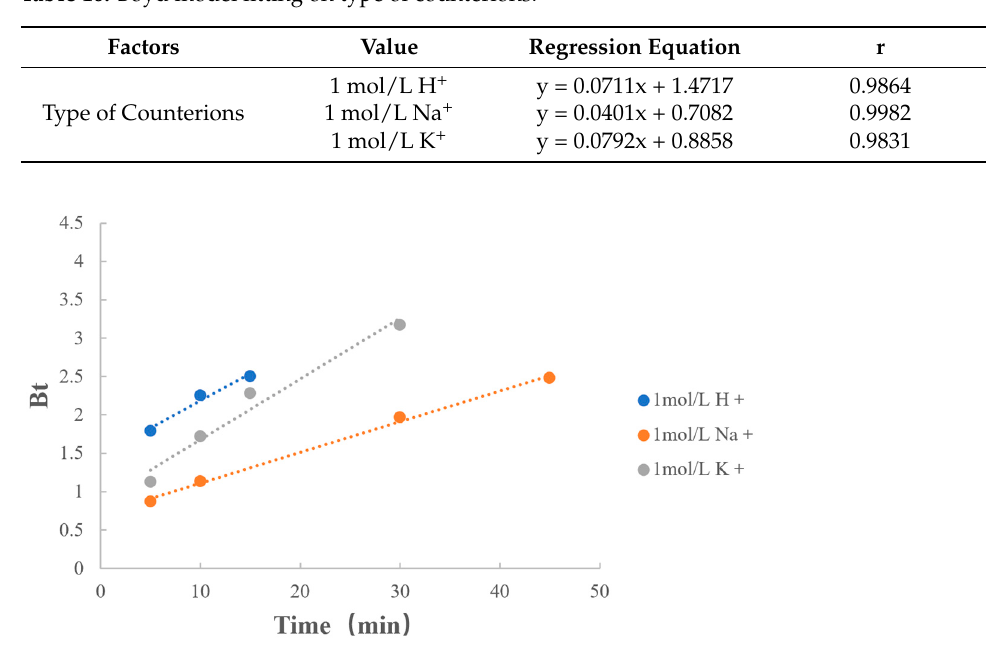
Table 11. Boyd model fitting on the concentration of counterions.